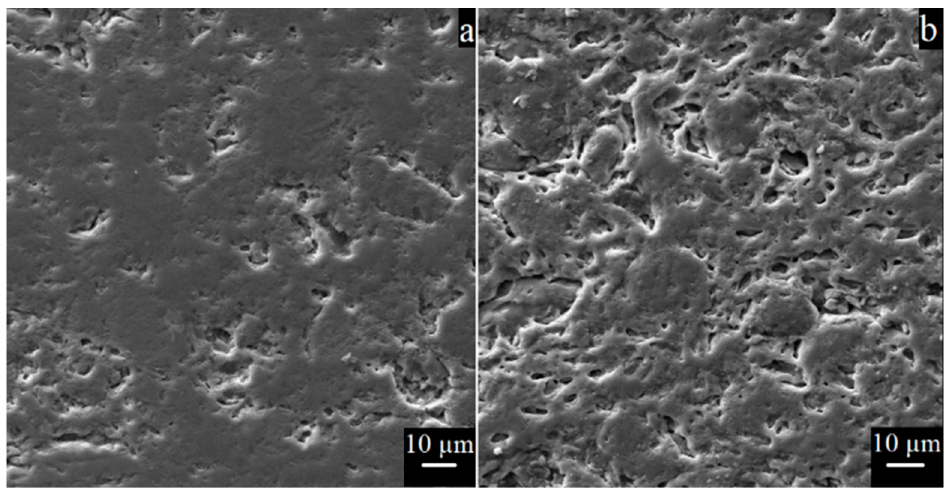
Figure 10. The SEM images of the brick samples, ( a ) Reference sample, ( b ) EPP-EPA (coarse). Table 8. Phase composition of Reference and EPP-EPA added bricks